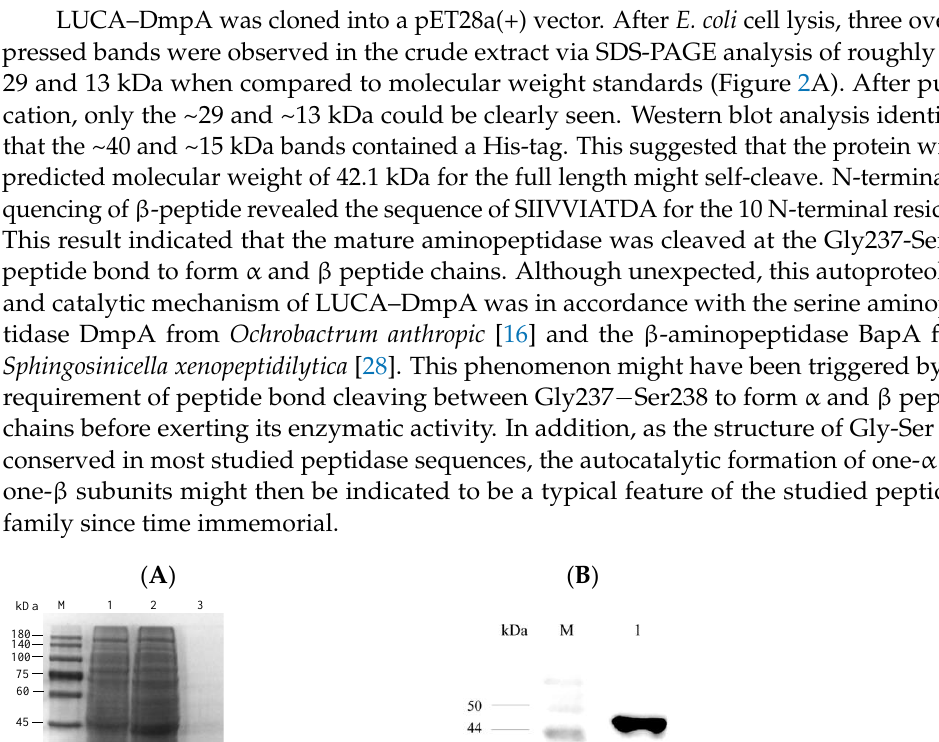
Figure 1. The maximum likelihood phylogenetic tree and multiple sequence alignments of protein sequences. ( A ) The phylogenetic tree was constructed via the maximum likelihood method using PhyML v 3.0. The simplified phylogenetic tree is presented as supplementary data (Figure S1). ( B ) Multiple sequence alignments of protein sequences performed using Clustal X 2.1 and visualized using ESPript 3.0 (WP_043062538.1 as template).